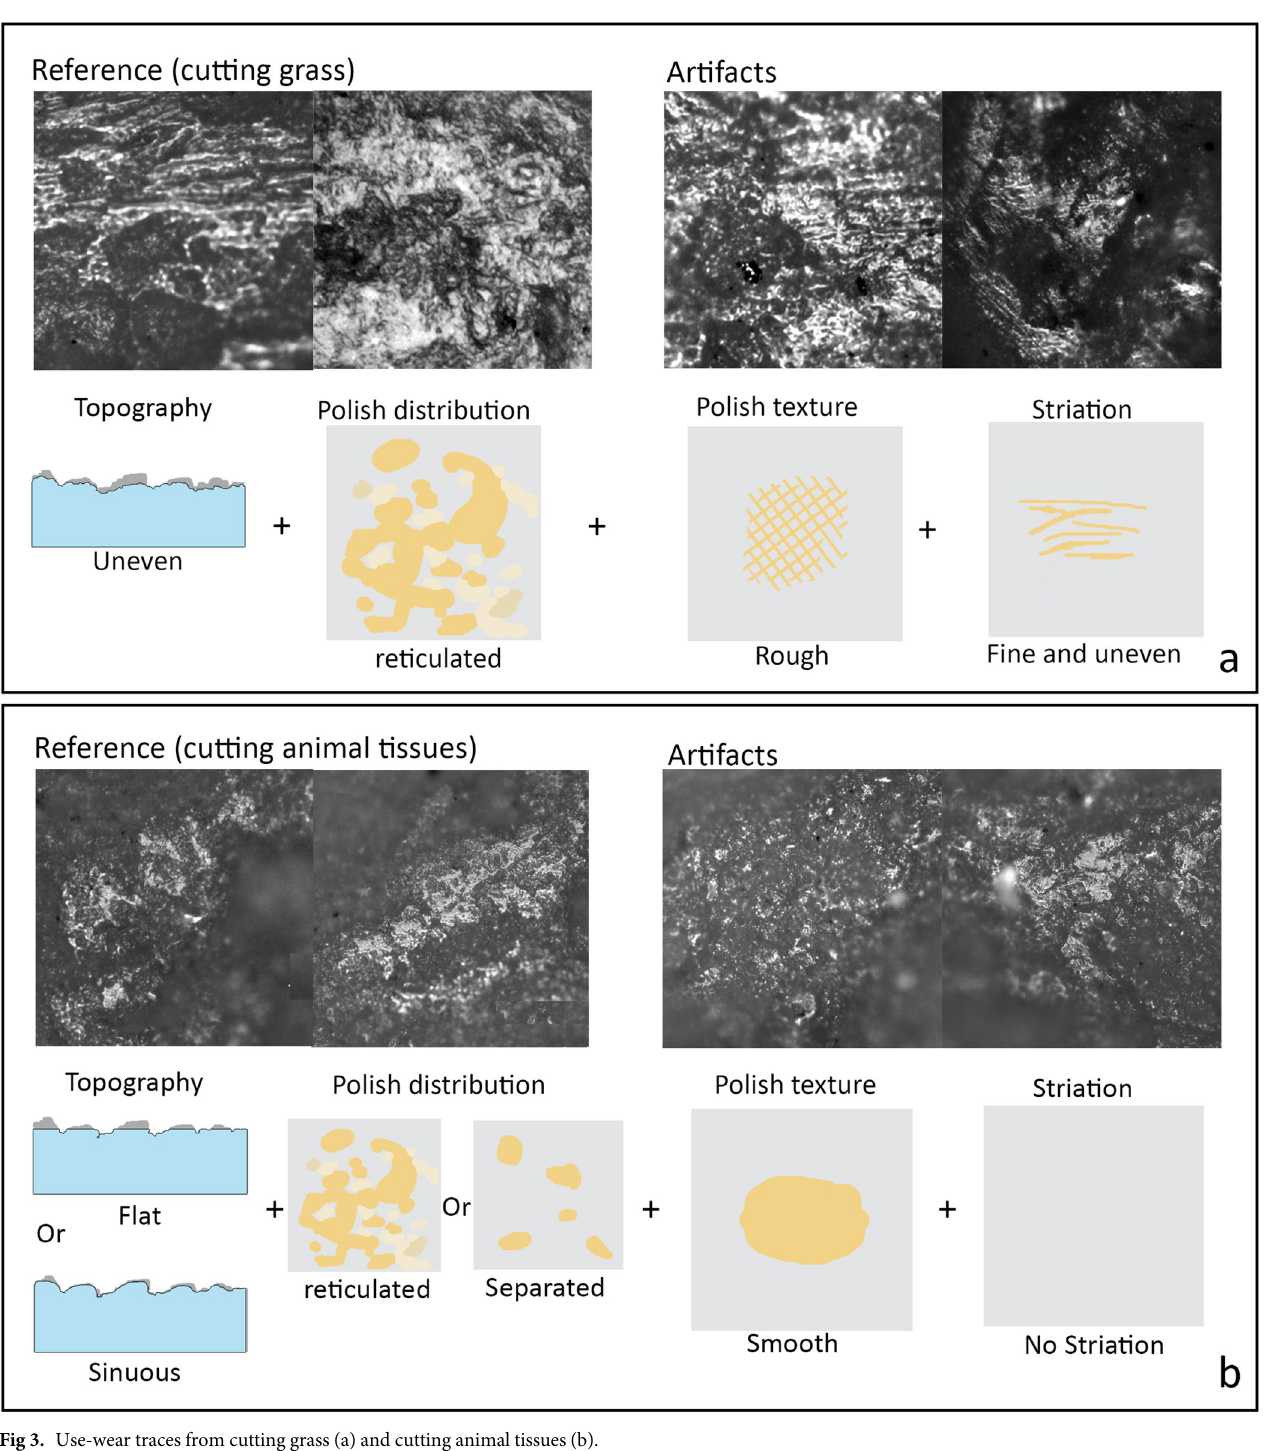
Fig 3. Use-wear traces from cutting grass (a) and cutting animal tissues (b).